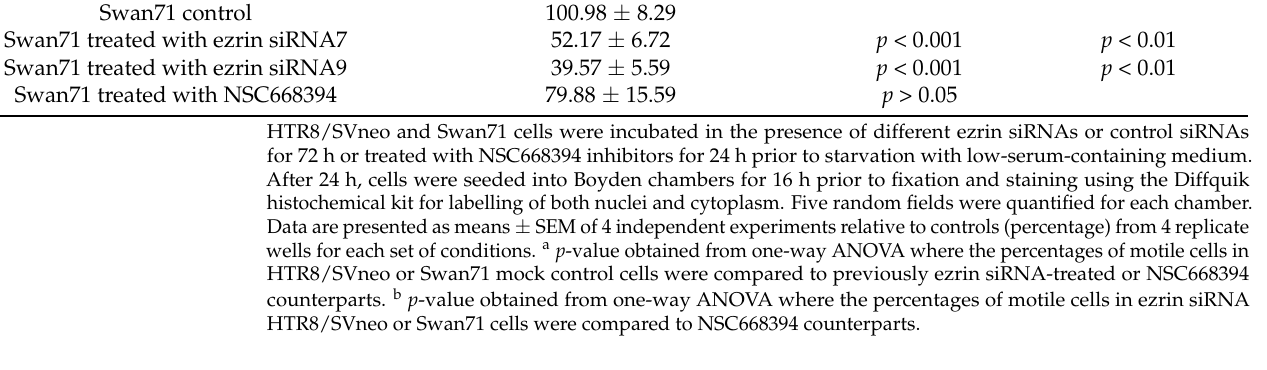
Table 4. Reduction in ezrin protein levels in trophoblast cells by siRNA delivery significantly increases the number of focal adhesions per cell.